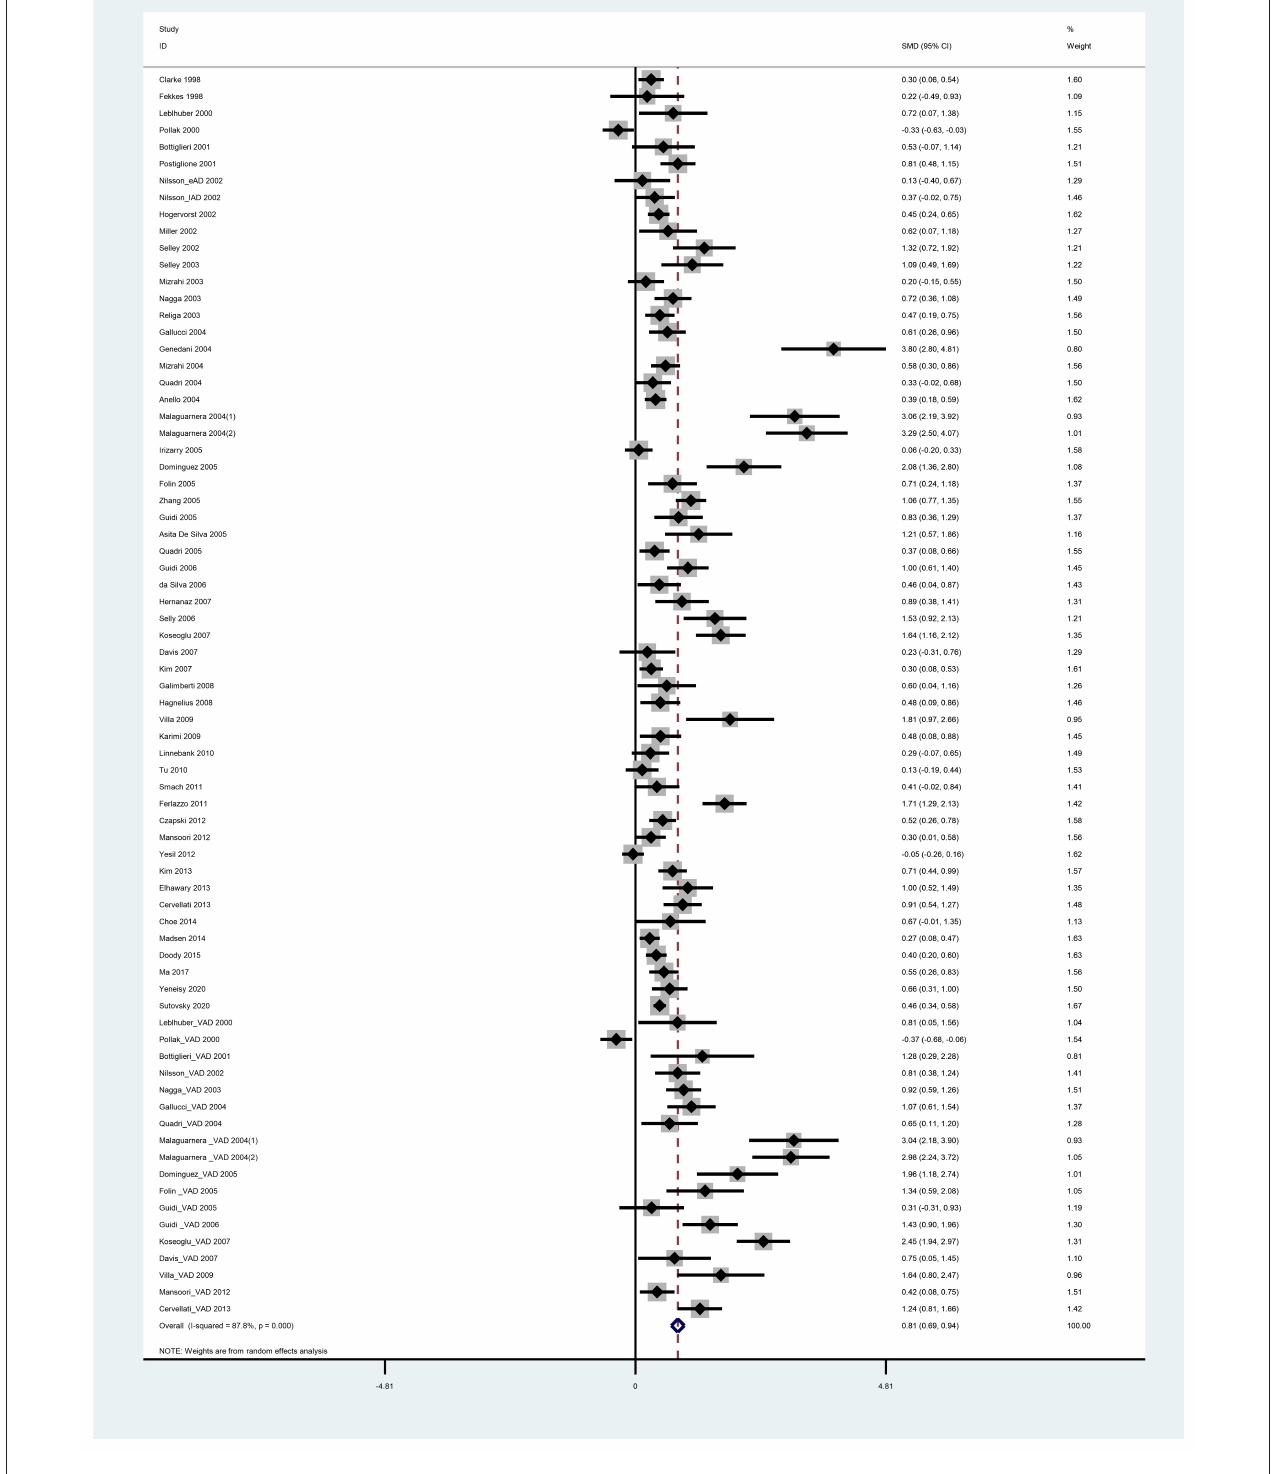
Frontiers in Aging Neuroscience |